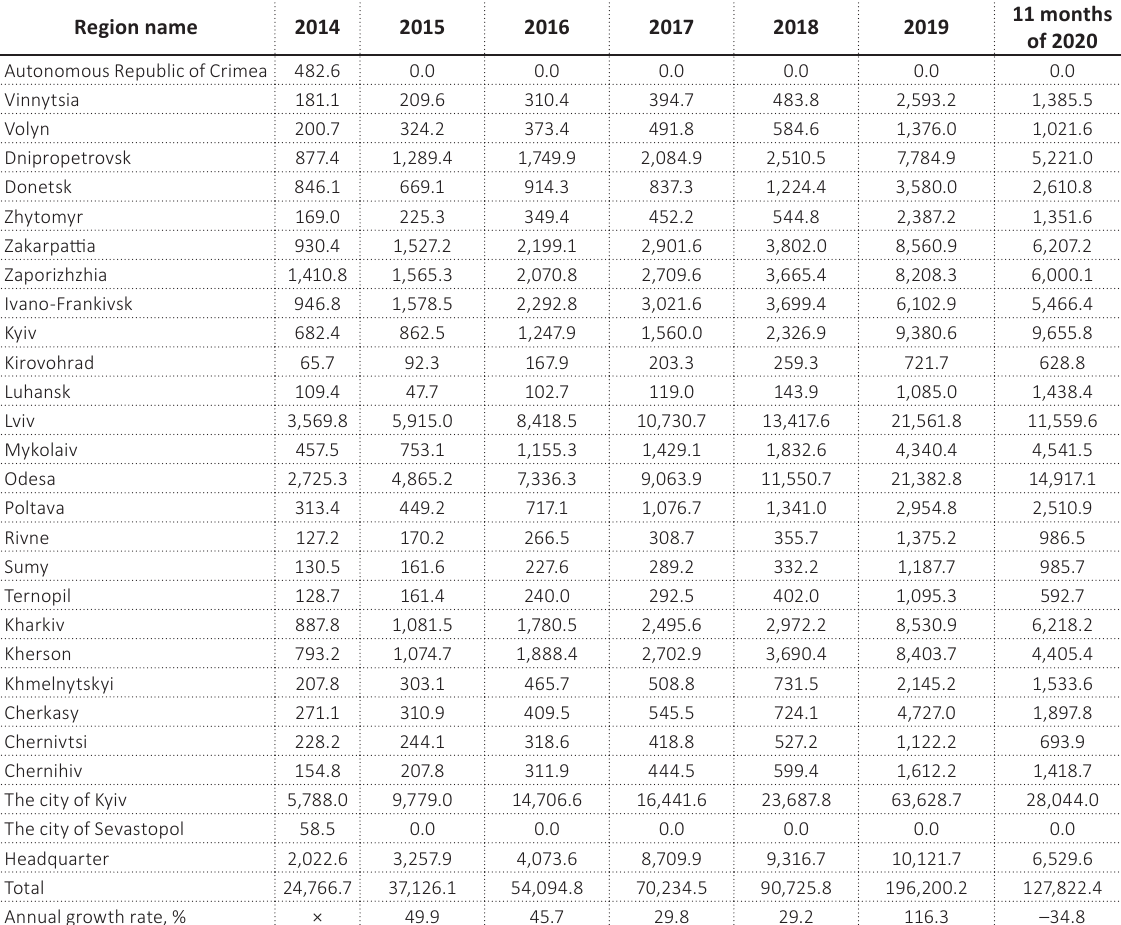
Table 1. Dynamics of tourist tax receipts to local budgets of Ukrainian regions in